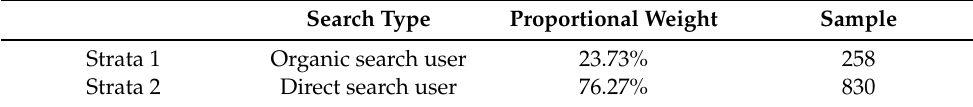
Table 1. Pre-test: Time a customer spends watching the product.